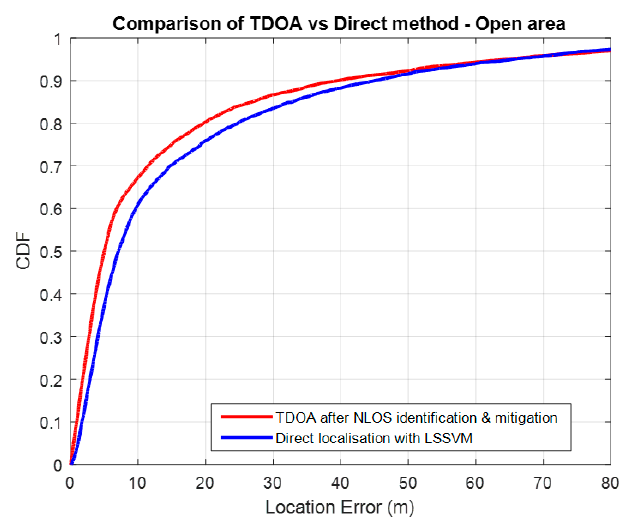
Figure 10. TDOA vs. Direct method in a LOS